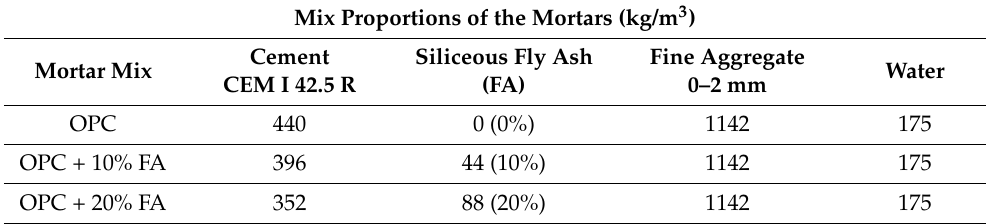
Table 2. Composition of mortar mixtures, w/b = 0.40 1